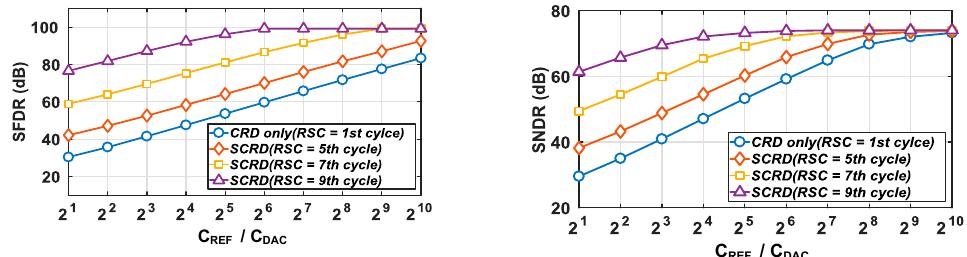
Figure 6. SFDR and SNDR of a behavioral simulation for a 12-bit SAR ADC according to C REF and the RSC.